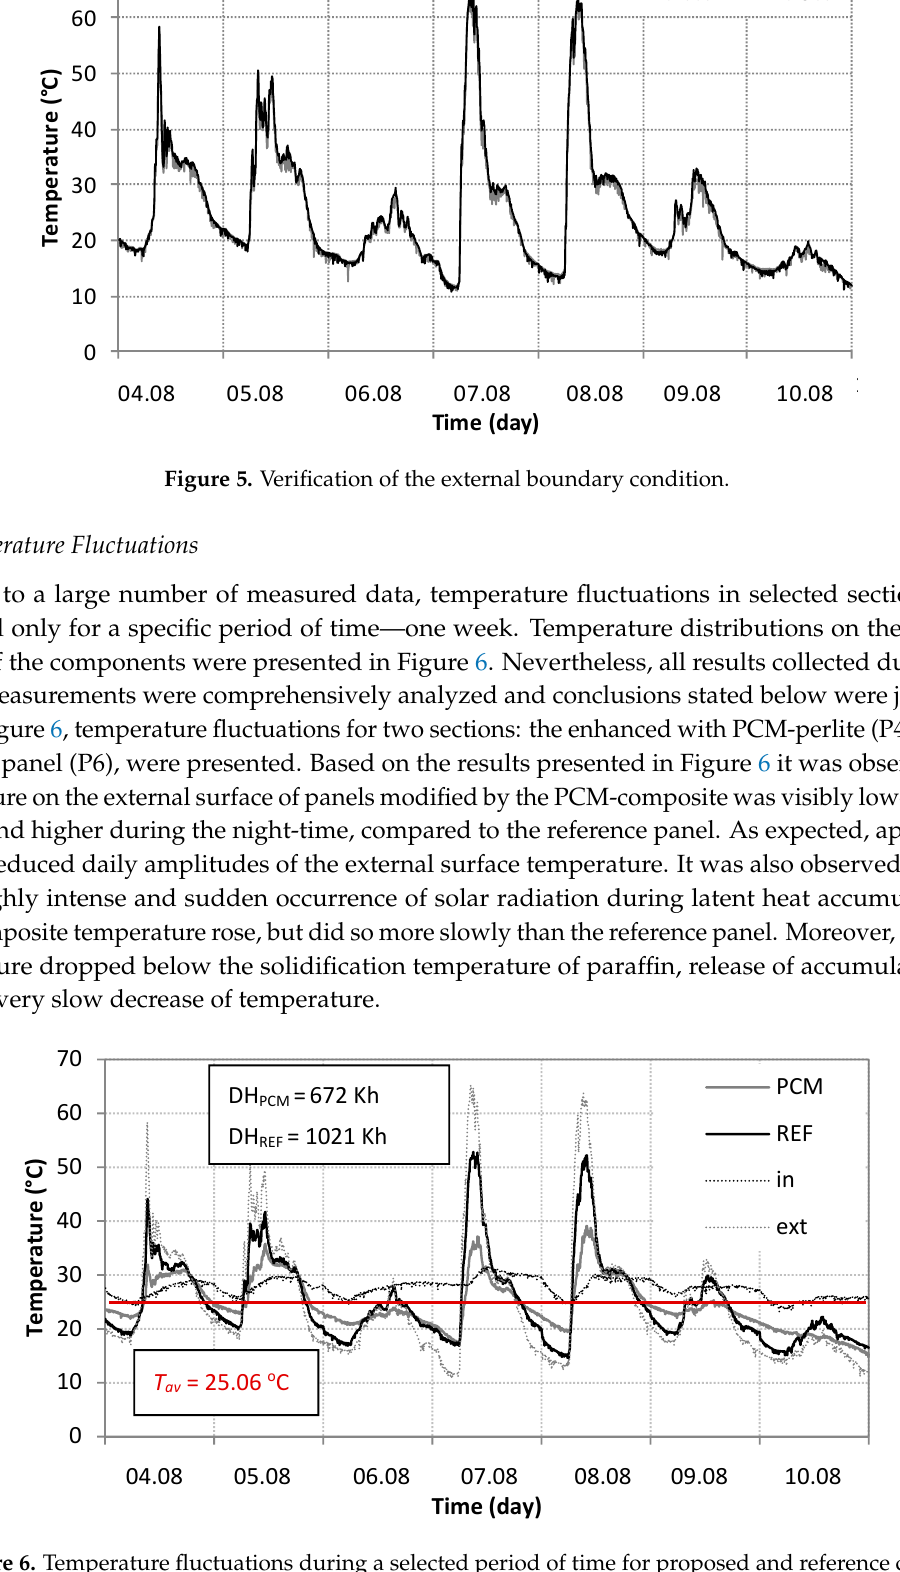
Figure 6. Temperature fluctuations during a selected period of time for proposed and reference cases (in—internal temperature T1, ext—external temperature T7). DH: degree hours.